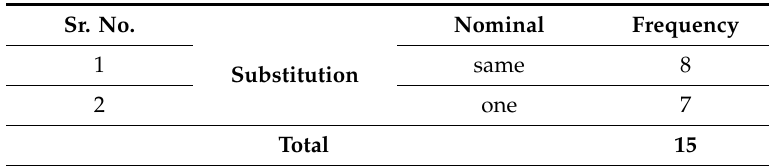
Table 26. Nominal